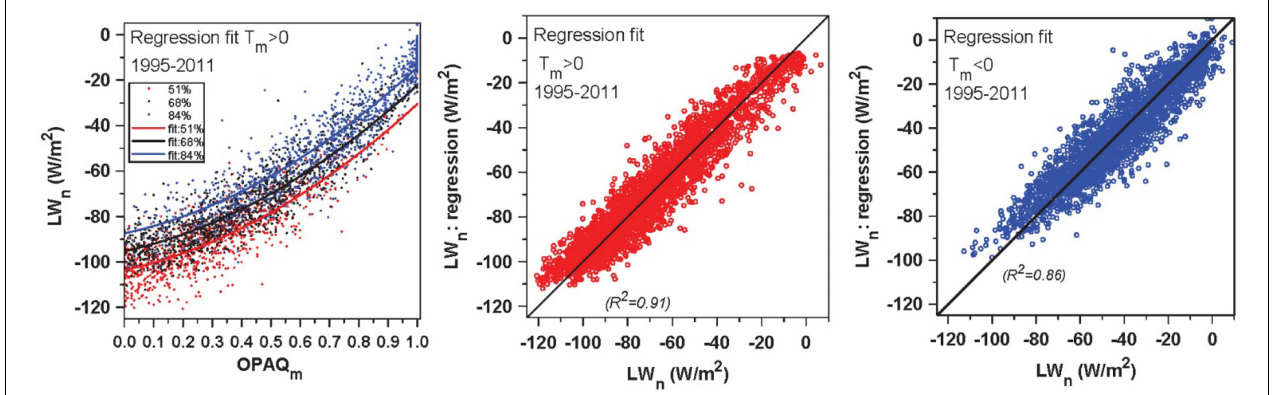
FIGURE 6 | Regression fits based on Equation (18a) for warm season and Equation (18d) for cold